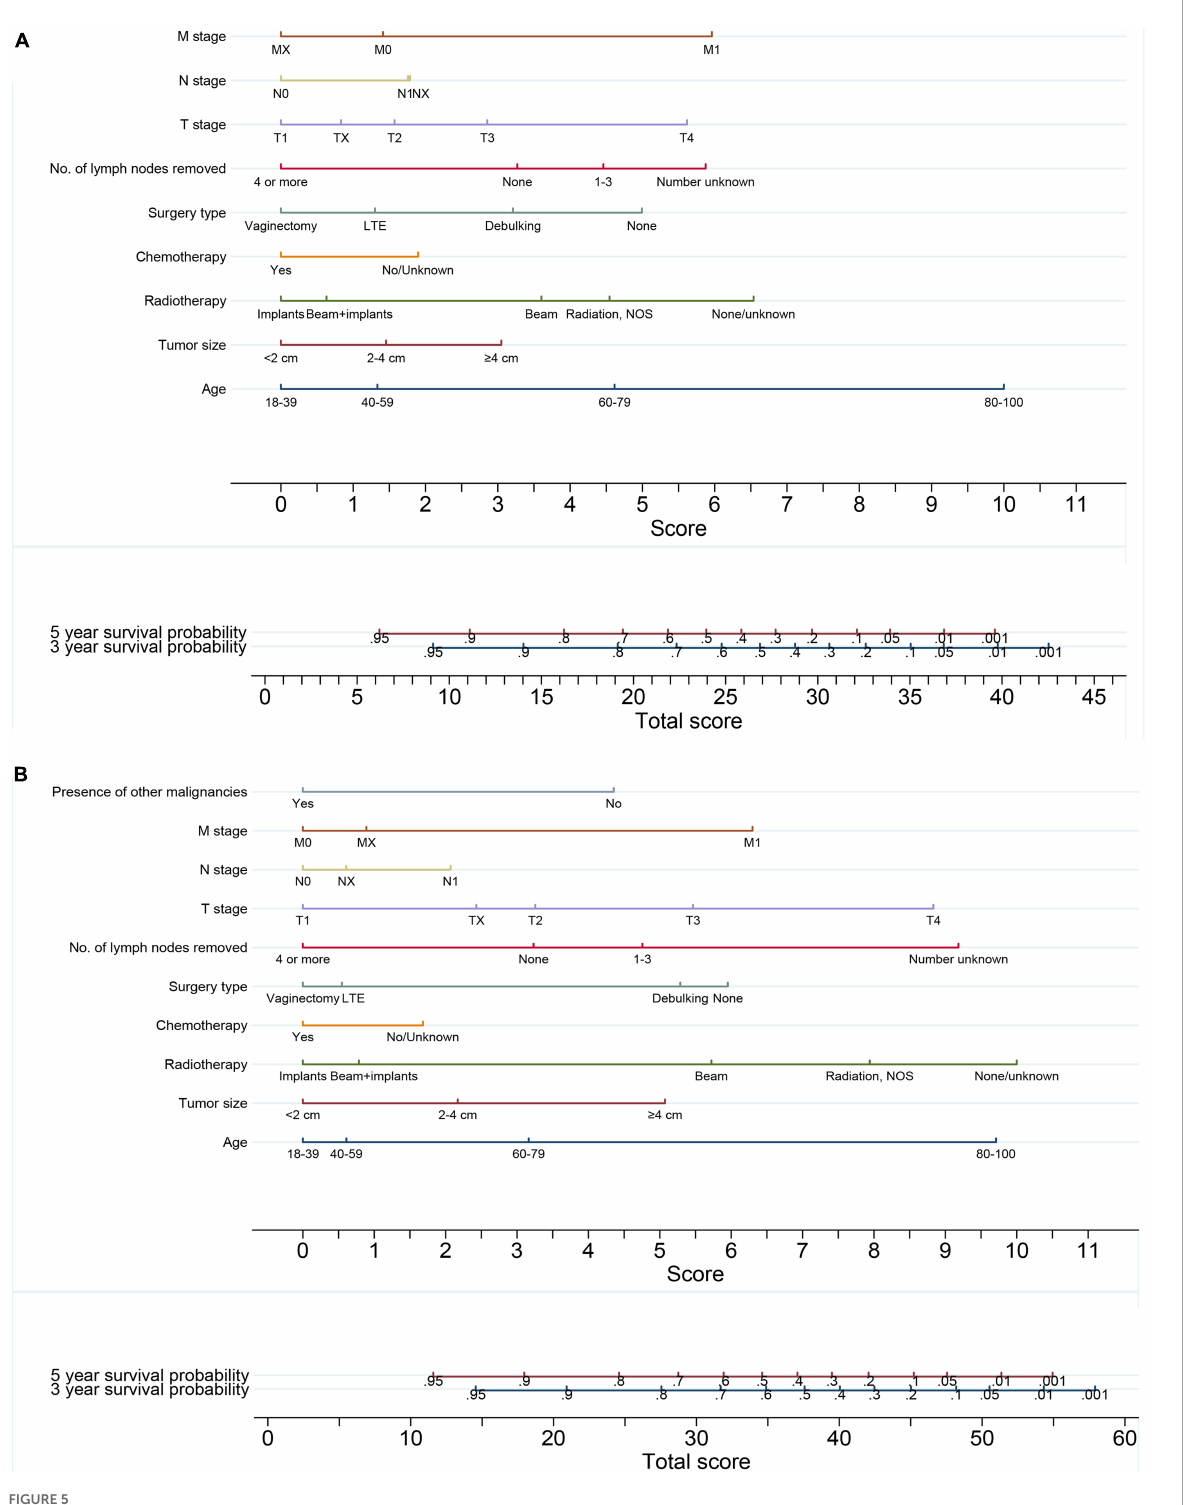
FIGURE5 Nomograms for predicting the 3- and 5-year (A) overall survival and (B) cancer-specific survival of vaginal cancer patients. By drawing a vertical line straight down to the horizontal axis labeled with points and summing every single score of each factor, the probabilities of 3- and 5-year survival were the probabilities corresponding to the total